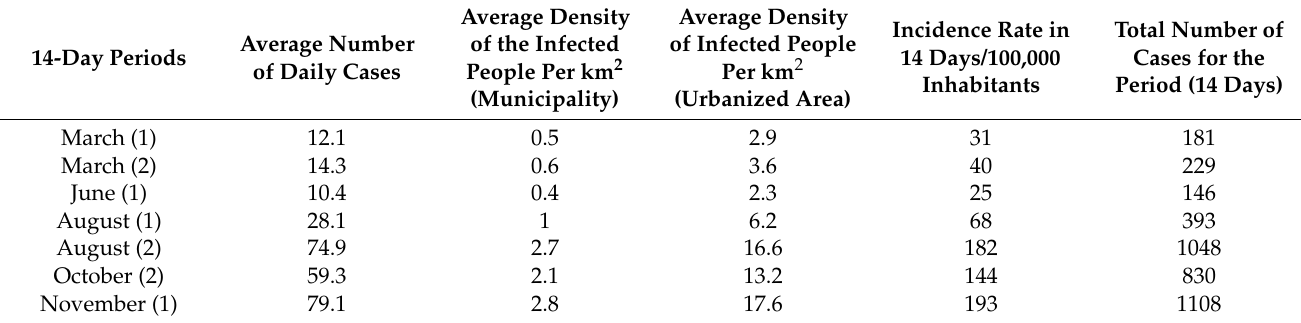
Figure 3. Weekly evolution of the number of people infected in the city (March to November 2020) and selected periods for the study of the spatial pattern of contagion. Table 1. Average indicators of the epidemic level of incidence in the city for the different selected analyzed periods.